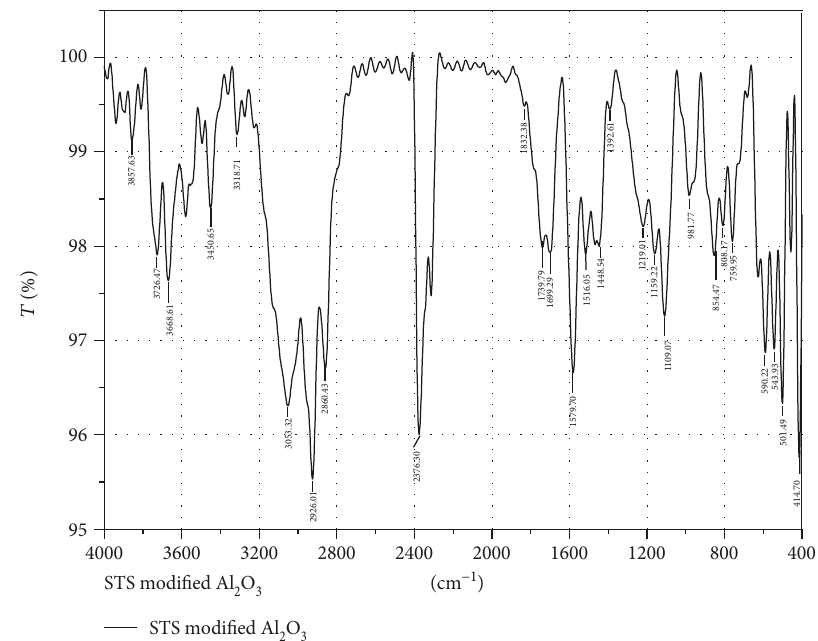
Figure 10: FTIR spectrum of γ -Al